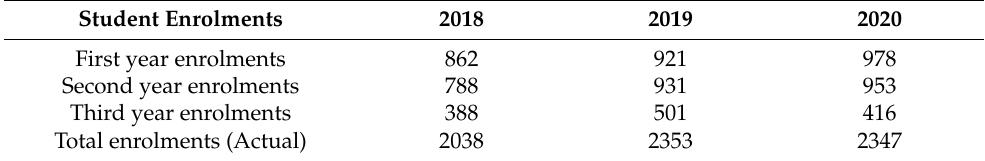
Table 1. Total enrolments over three-year